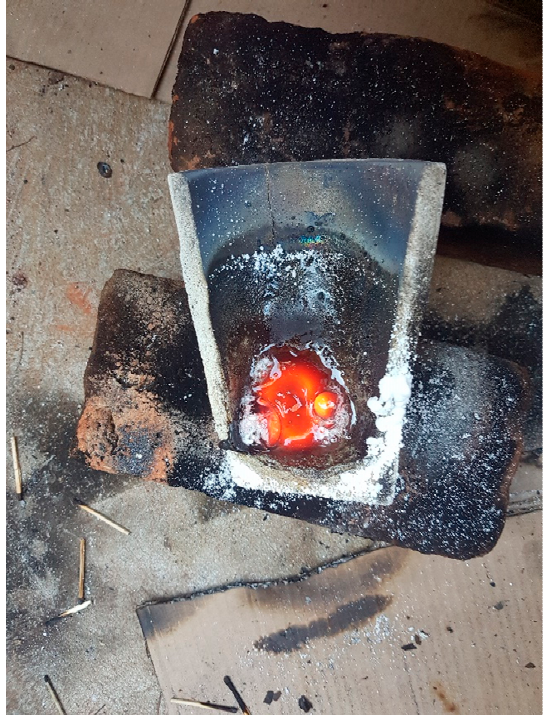
Figure 11. Half crucible containing the molten slag and button just after smelting.